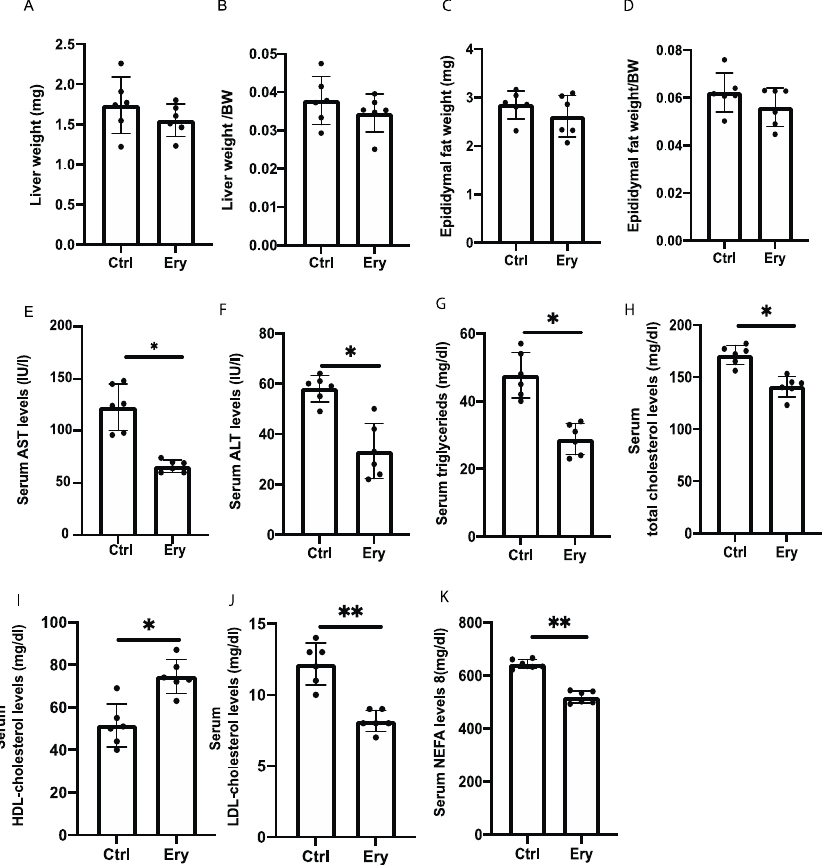
Figure 2. The weight of organs and blood biochemistry test results. Erythritol decreased hepatic enzyme and improved serum lipid levels. ( A , B ) Liver weight and liver weight:body weight ratio ( n = 6). ( C , D ) Epididymal fat weight and epididymal fat weight:body weight ratio ( n = 6). ( E – K ) Blood biochemistry test results for serum AST, ALT, triglyceride (TG), total cholesterol, low-density lipoprotein (LDL) cholesterol, and nonesterified fatty acid (NEFA) levels ( n = 6). Data have been represented